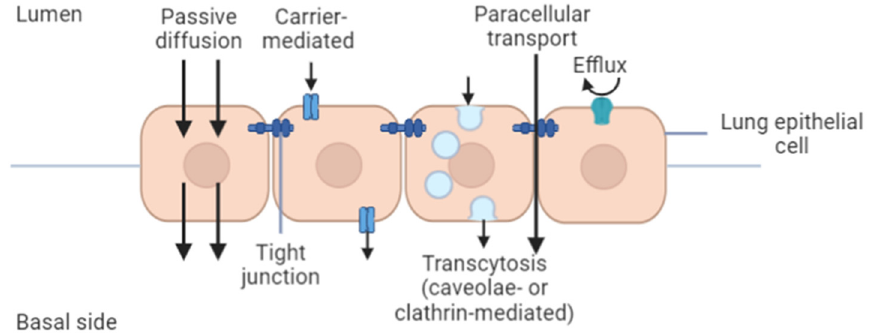
Figure 2. Schematic diagram of different absorption mechanisms in lung epithelium (created using BioRender.com, accessed on 2 April 2021).